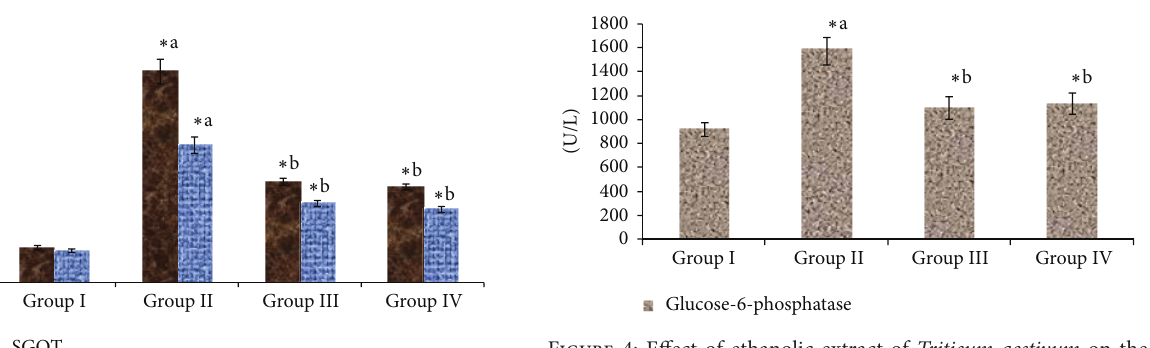
Figure 4: Effect of ethanolic extract of Triticum aestivum on the glucose-6-phosphatase level in STZ-induced model. Values are the mean ± SD for six animals in each group. Values are statistically significant at ∗ P < 0.05; statistical significance was compared within the groups as follows. a Diabetic rats were compared with normal rats. b Glibenclamide and Triticum aestivum treated diabetic rats were compared with diabetic rats.